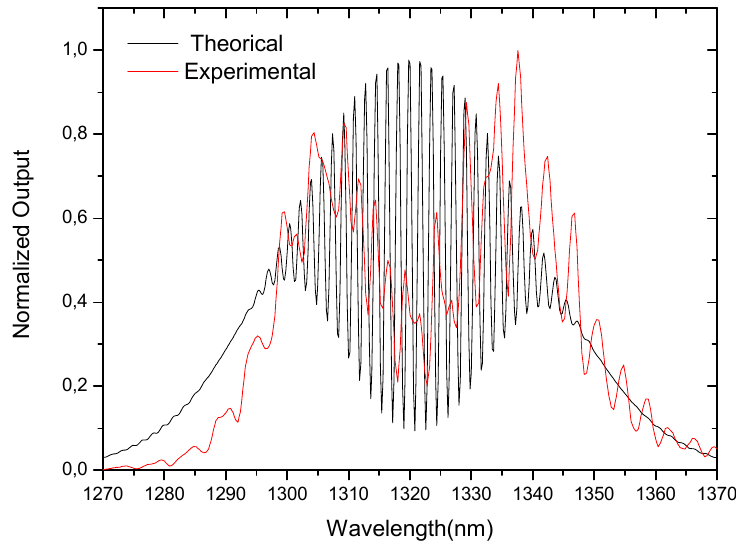
Figure 2. Spectrum of an LPG-assisted modal interferometer (theoretical and experimental results) for a cavity length of ~140 mm (it is involved the 4th order cladding mode).